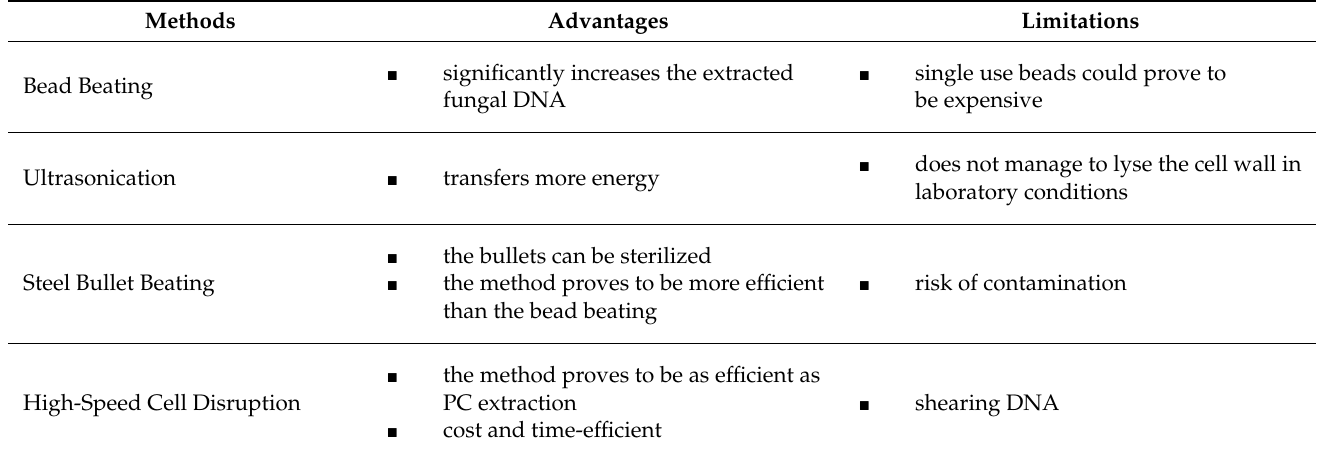
Table 3. Proposed methods for mechanical extraction